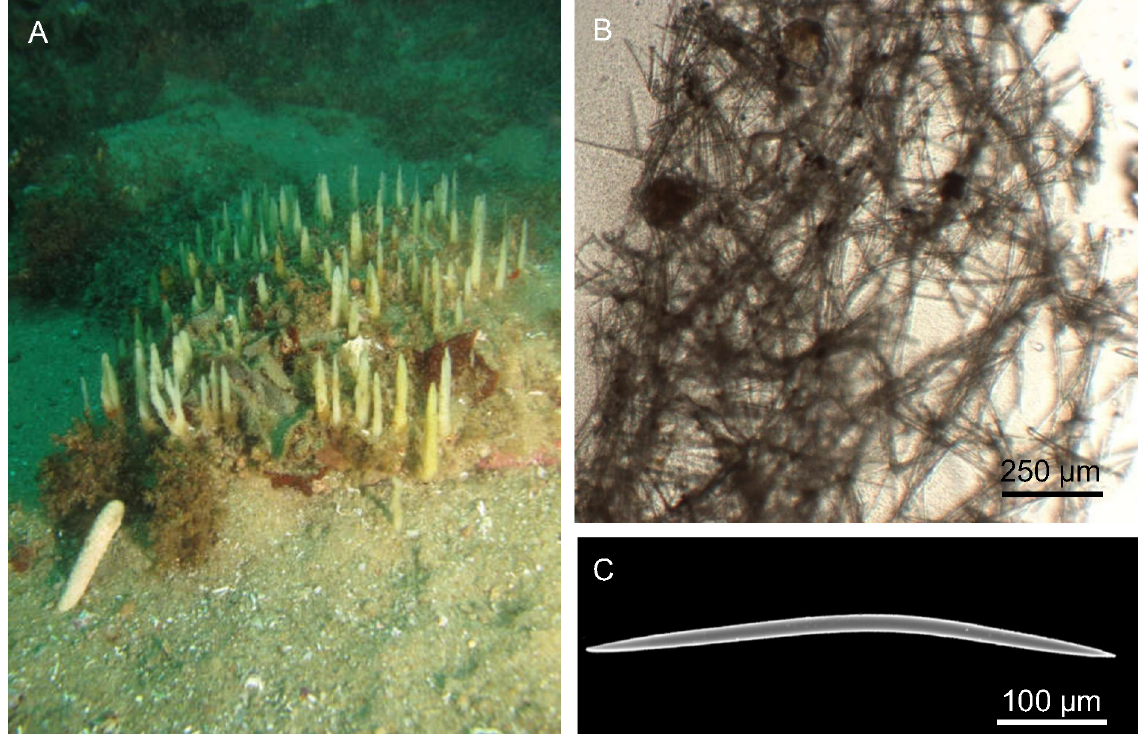
Fig. 25. Ciocalypta tyleri Bowerbank, 1873. A . Fistules erect coming out the sediment (PdO16). B . Skeleton of the basal part. C . Curved